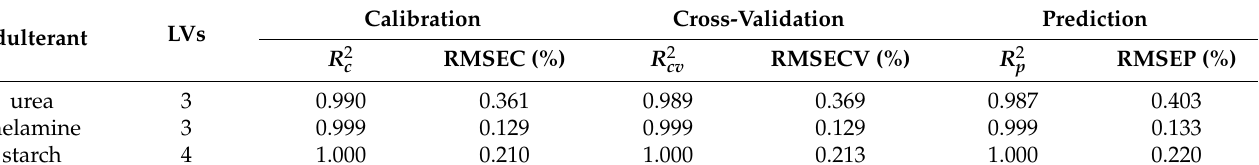
Table 4. Performance of the multispectral PLSR models for quantification of each of the three adulterants based on the characteristic wavelengths.